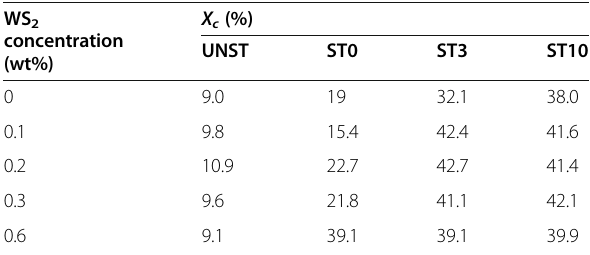
Table 2 Percentage of crystallinity ( X c ) evaluated from DSC data (Fig. 8) for PLA and PLA-WS 2 samples